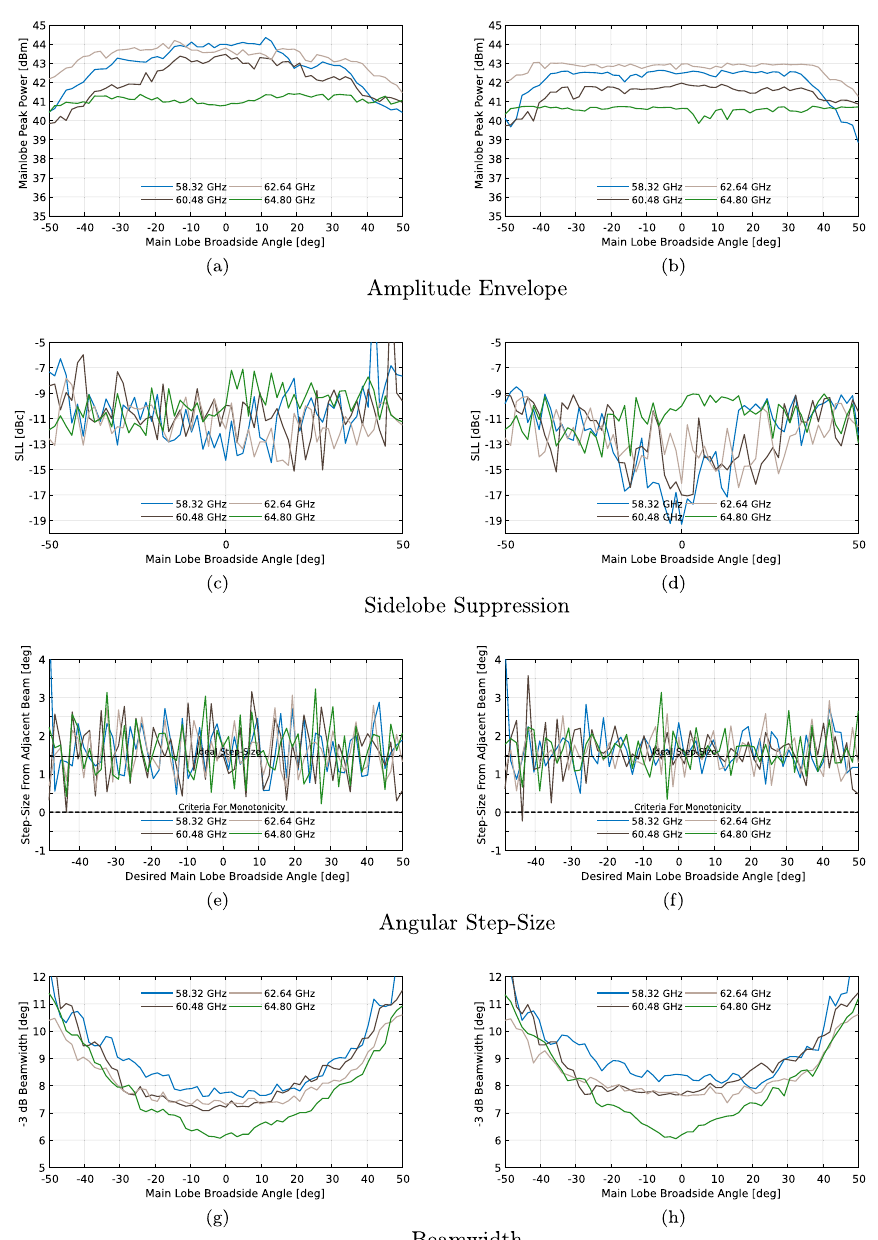
Fig. 13 Comparison of two beam-books; (left) phase shifters set to corner settings (maximum power), (right) generated with the proposed algorithm ( K 10, N 1, M 1, SLL < 9 dBc, flattened amplitude). The signal = = = − chain is saturated. a Mainlobe peak power when phase shifters are set to corner settings. b Mainlobe peak power when phase shifters are set using the proposed algorithm. c SLL when phase shifters are set to corner settings. d SLL when phase shifters are set using the proposed algorithm. e Step size with adjacent beam when phase shifters are set to corner settings. f Step size with adjacent beam when phase shifters are set using the proposed algorithm. g 3 dB beamwidth when phase shifters are set to corner settings. h 3 dB − − beamwidth when phase shifters are set using the proposed